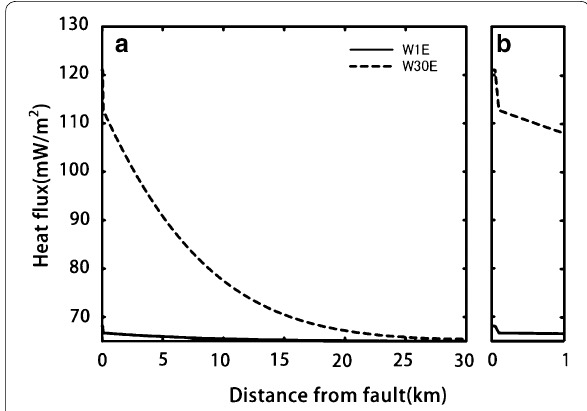
Fig. 7 a Surface heat flow for simulation of interplate ( broken line ) and intraplate ( solid line ) strike-slip faults. b Enlarged view of the fault core, the sharp peak above the fault ( x = ∼ 0 ) was created by fault frictional